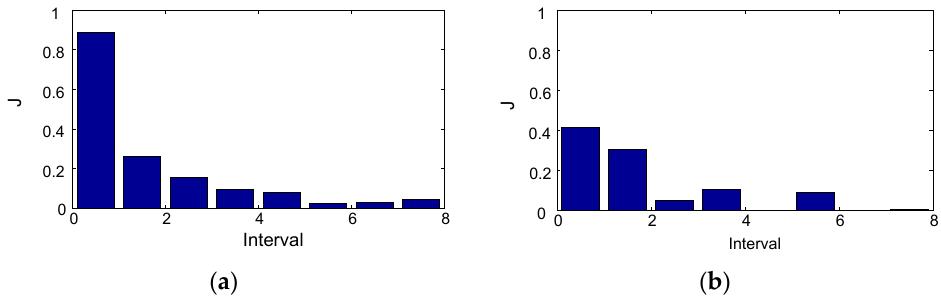
Figure 13. Gradient of AE signals for eight 1 ms intervals for joints with normal and low bonding strength.